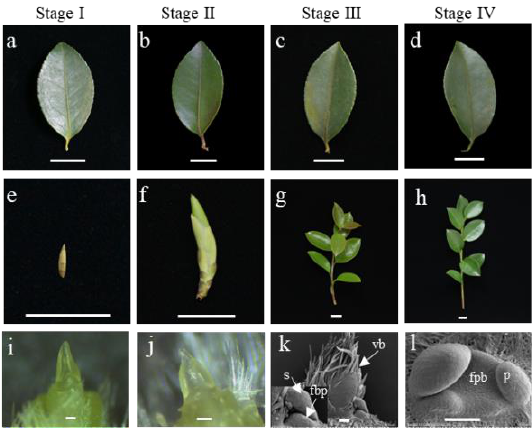
Figure 1. Developmental stages of old in C. oleifera . Old leaves ( a – d ) are referred to as the leaves formed in the last year. Vegetative buds in stages I ( e ) are grown at axils of old leaves and will develop into sprouted buds ( f ) and differentiate into new leaves ( i , j ). The new shoots in stages III ( g ) and IV ( h ) are derived from sprouted buds in panel ( f ). Flower buds in stages III and IV were located at the base of the vegetative buds of new shoots ( k , l ). vb: Vegetative bud, fpb: Flower primordium bud, s: Sepal, p: Petal. The scale bars in ( a – h ) and ( i – l ) indicate 1.5 cm and 100 µ m,